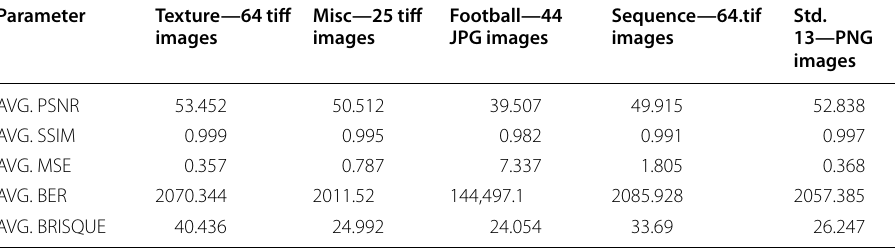
Table 1 Full-reference quality metric and No-reference quality metrics—analysis on standard set of